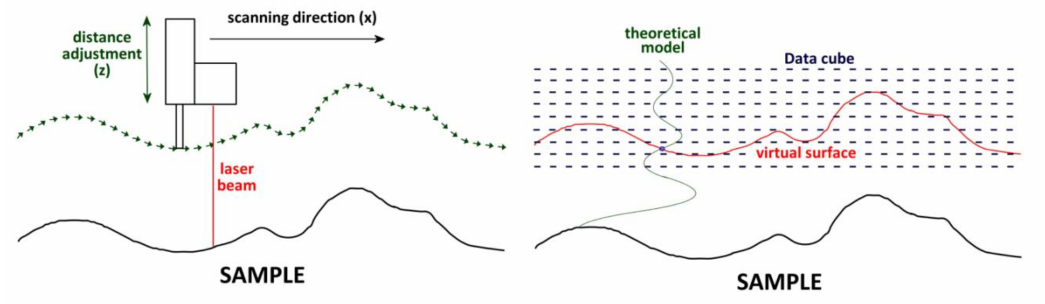
Figure 14. Methods for correcting the e ff ect of surface topology: ( left ) surface following; ( right ) data cube interpolation.